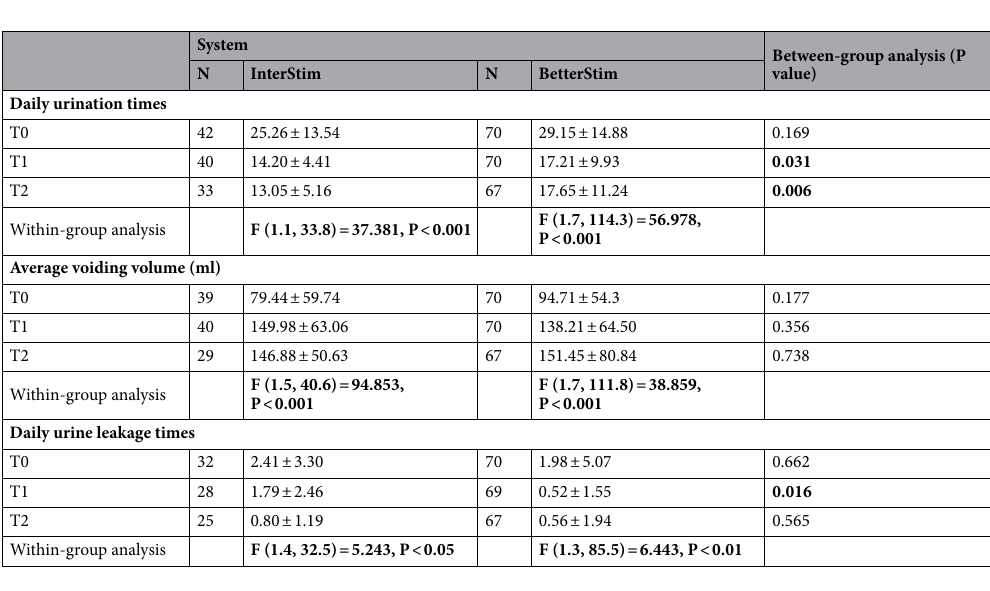
Table 2. Objective indicator data. T0 baseline data, T1 experience period data, T2 last follow-up data. Significant values are in